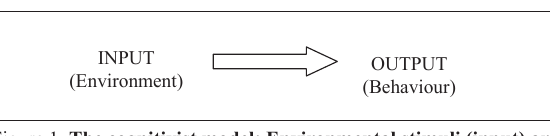
Figure 1. The cognitivist model: Environmental stimuli (input) are translated by fi xed associations (i. e. switches) to the behaviour